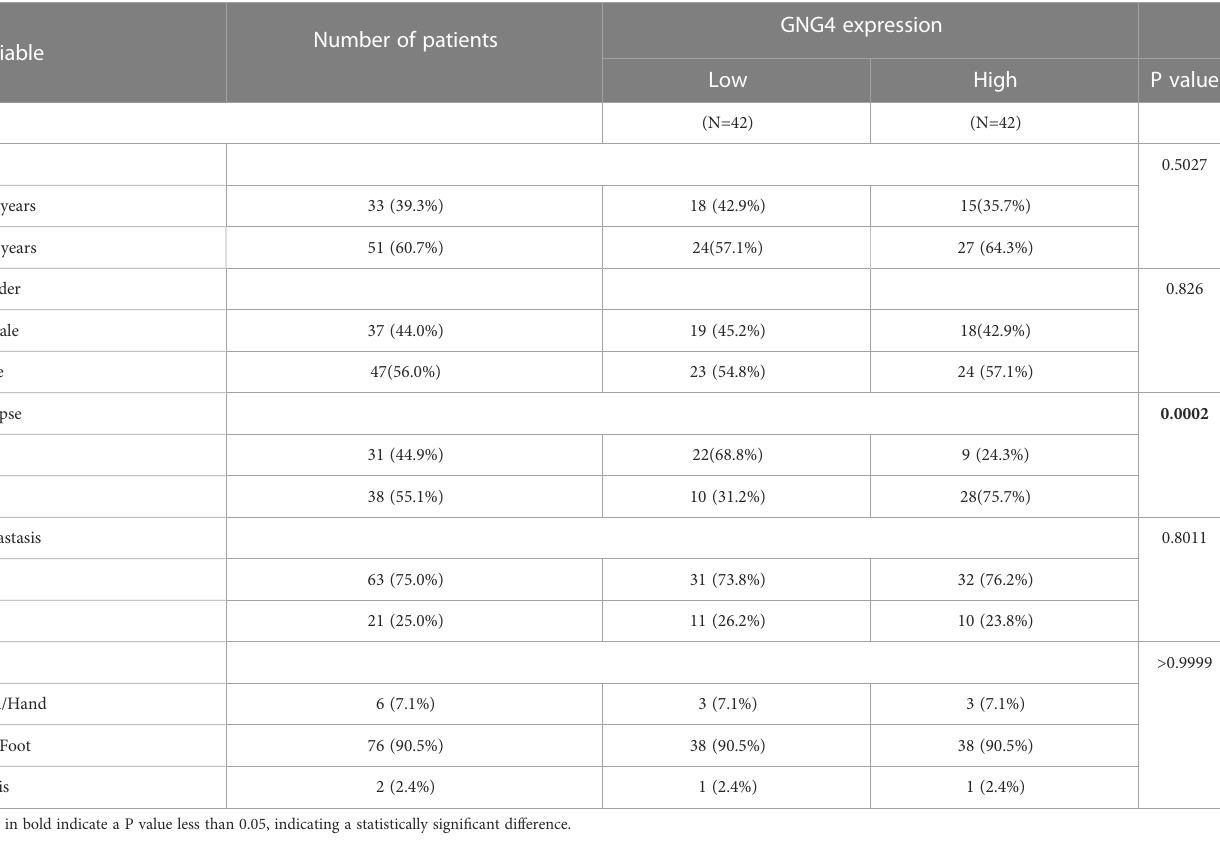
TABLE 1 Relationship between GNG4 expression and clinical parameters in TARGET